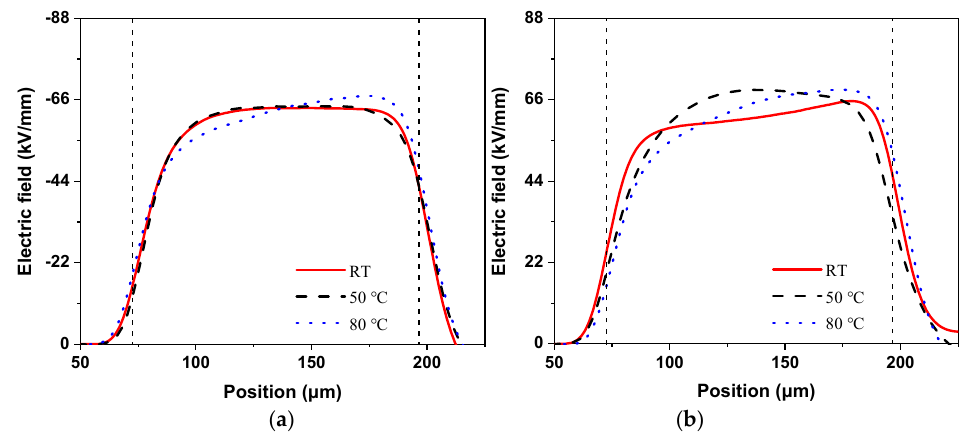
Figure 6. Electric field results under DC voltages: ( a ) positive voltages, ( b ) negative voltages.